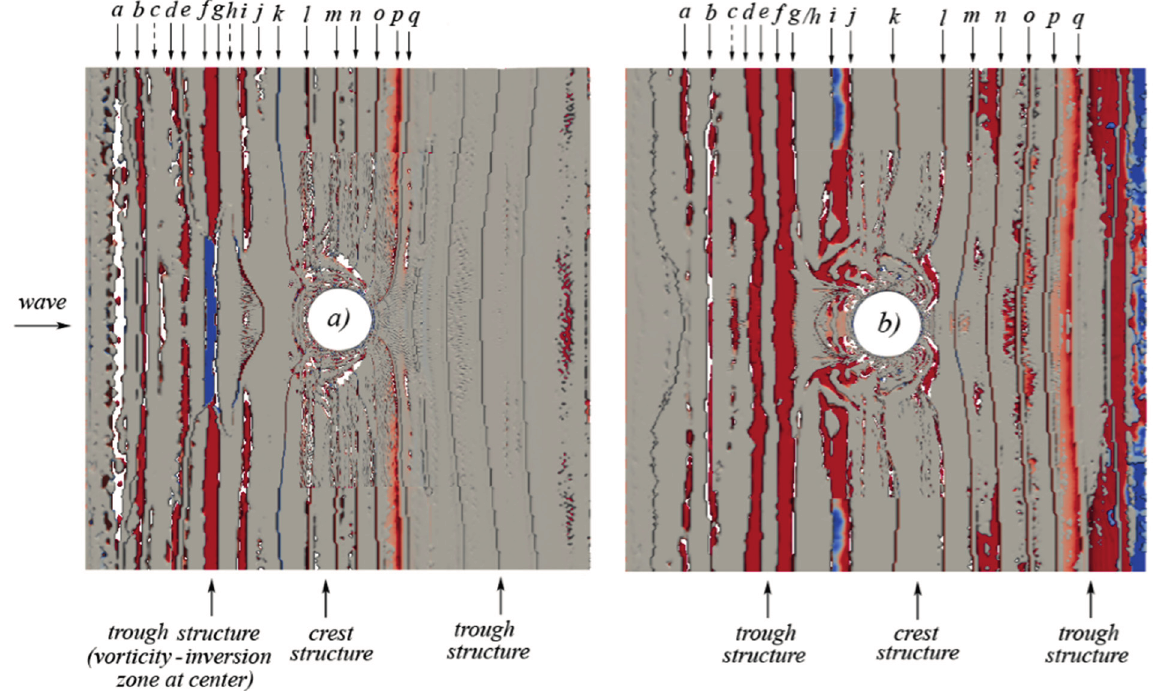
Figure 18. Flow structures as obtained from the solution of the